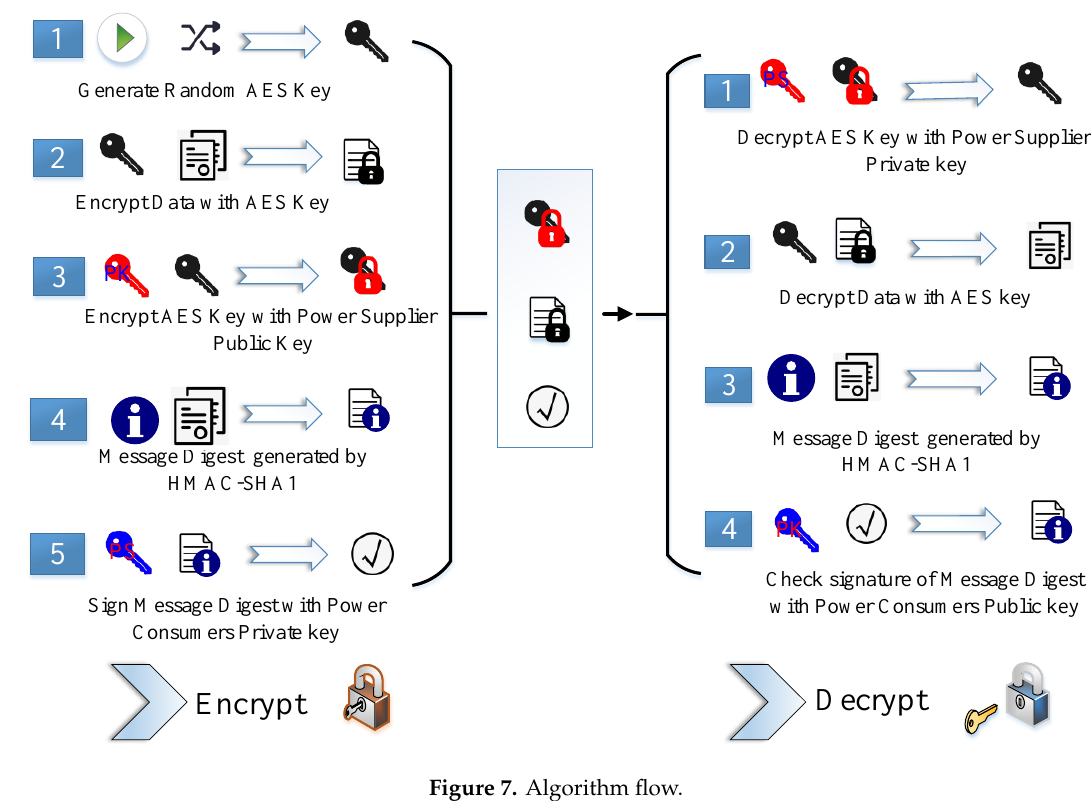
Figure 7. Algorithm flow.